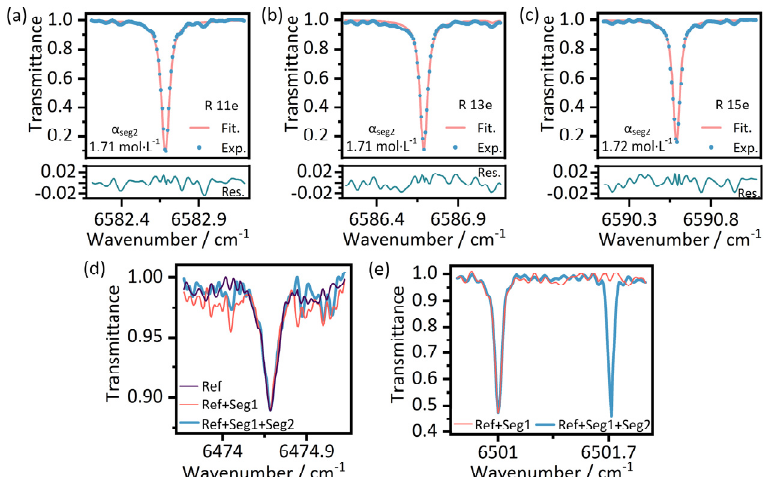
Figure 6. The magnified view of the absorption lines of the three gases. ( a ) ( b ) and ( c ) Three different absorption lines of 12 C 2 H 2 and the results of the corresponding fitting for the concentration retrieval using the least squares method. ( d ) Absorption line of H 13 CN from the three different spectra. ( e ) Absorption lines of 13 C 2 H 2 (left) and 12 C 2 H 2 (right).